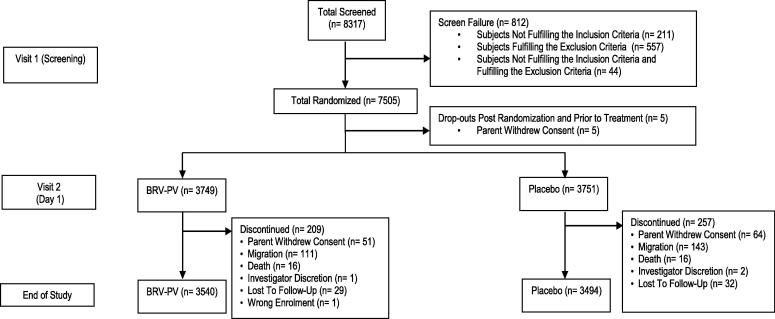
Study flowchart.